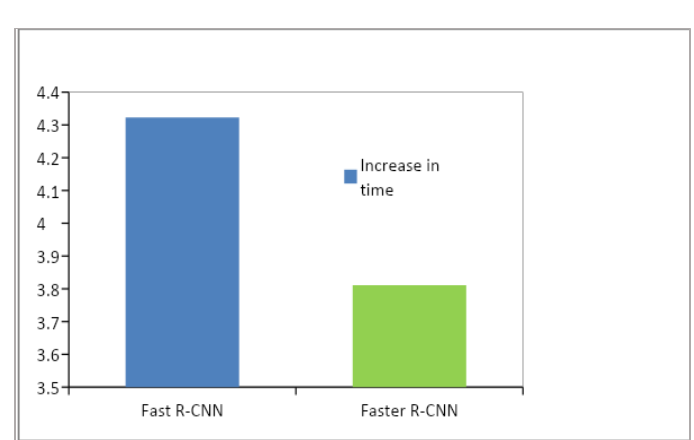
Figure 18. Time is taken to detect.